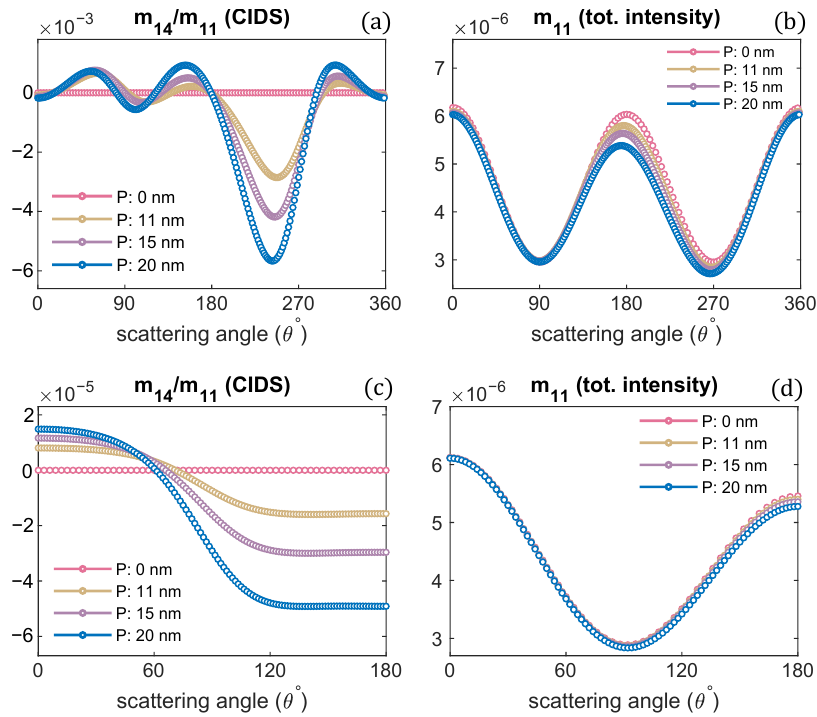
Figure 2. Pitch of chromatin solenoid is varied; the angular behaviour of CIDS and total scattered intensity is presented, respectively: ( a , b ) at a fixed orientation ( α , β , γ ) = ( 0,0,0 ) , ( c , d ) orientation averaging is